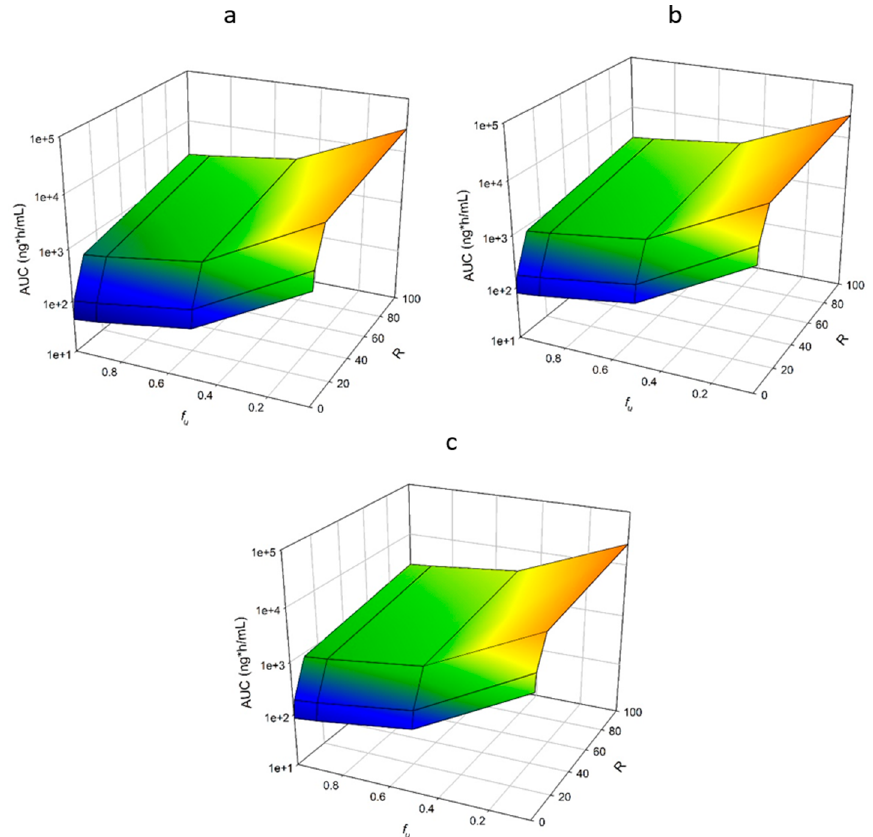
Figure 5. Impact of Fraction Unbound and Competitive Inhibition on AUC of Nifedipine. The impact of concurrent changes in f u and competitive inhibition was investigated. f u was varied from 0.04 to 1.0, and the factor R ([I]/ K i ) was varied from 0 to 100. Age ranged from 21 to 65 years, and simulations were conducted with varying the degrees of RI by utilizing the following populations, ( a ) Sim ‐ Healthy Volunteers; ( b ) Sim ‐ RenalGFR_30 ‐ 60; ( c ) Sim ‐ RenalGFR_less_30.